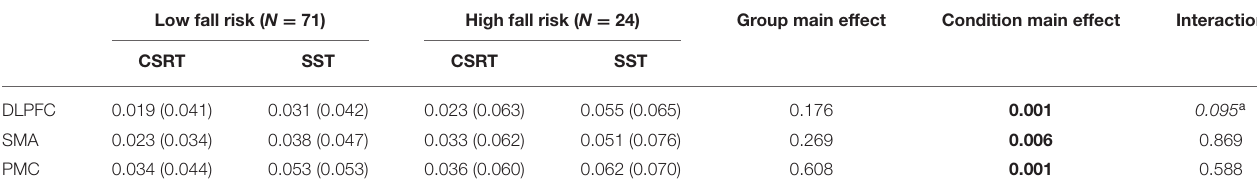
TABLE 5 | Relative oxyhemoglobin (HbO2) concentration ( µ mol/L) in the cortical regions of interest by group in the choice stepping reaction time (CSRT) test and Stroop stepping test